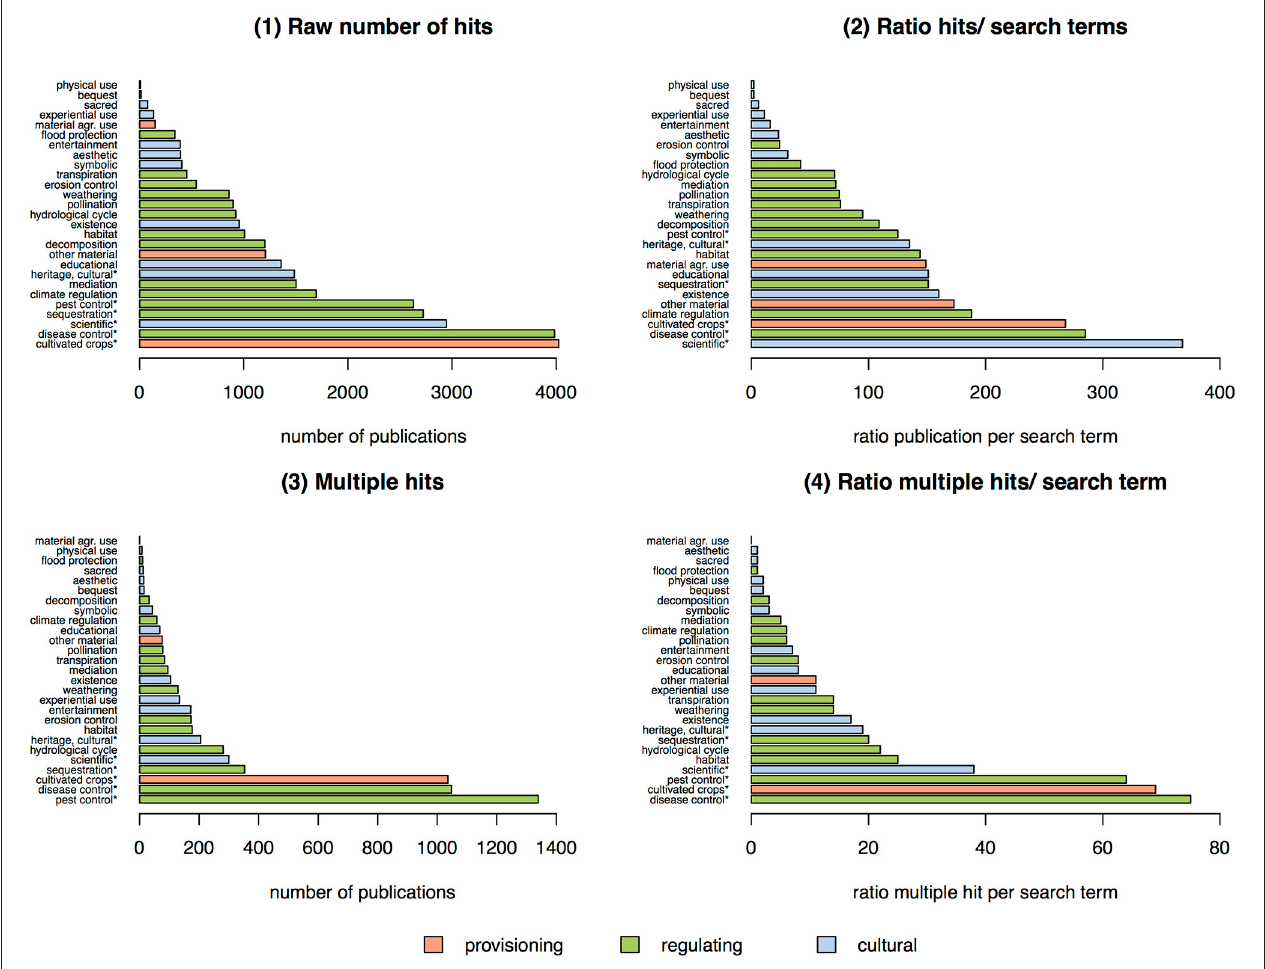
FIGURE 3 | Comparison of publications found for single ecosystem services in vineyards (research objective 2), identified from the full literature review using search terms from Table 1. We compared the “hits” (the number of publications returned for each search for the different ecosystem services in vineyards) in four ways: (1) the raw number of hits, (2) a ratio of the number of hits and the number of search terms, (3) the number of papers that were found at least twice for one ecosystem service by using different search terms within one service class (multiple hits), and (4) a ratio between the multiple hits and the number of search terms. We identified six key ecosystem services as the most widely researched, based on their high rating in at least three out of the four methods (indicated with *).